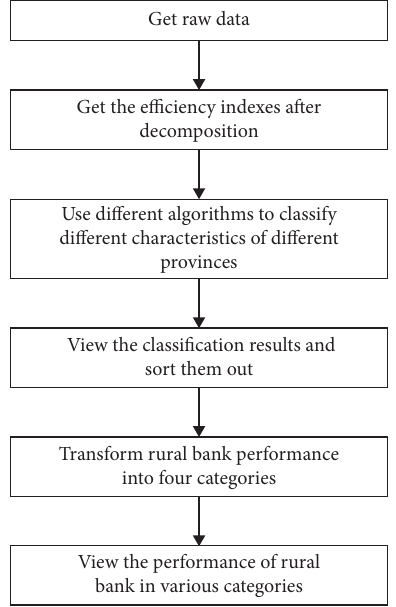
Figure 1: The experimental process